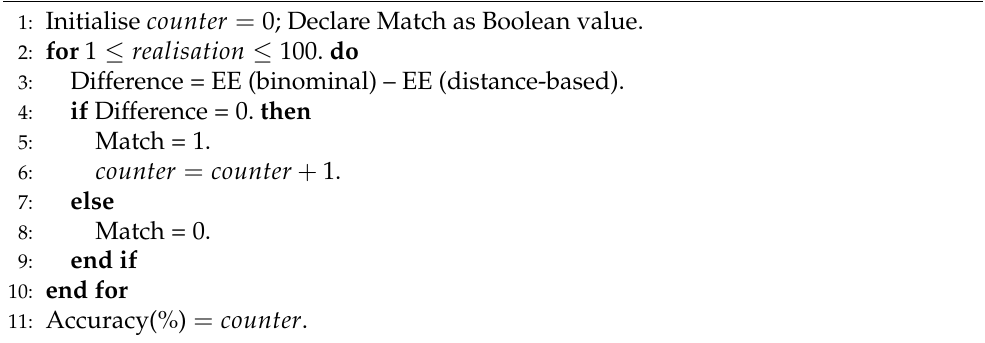
Algorithm 4 Distance-based performance validation